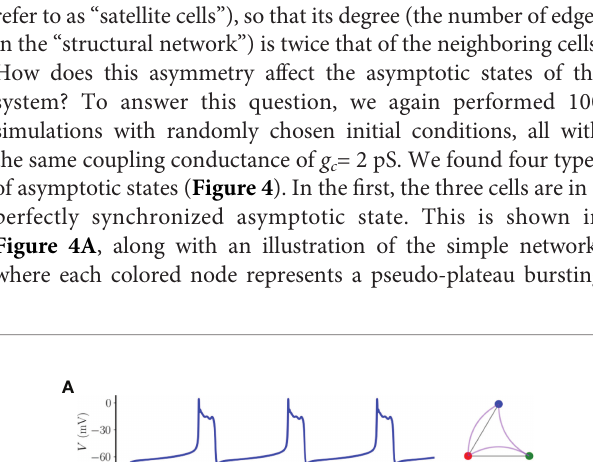
FIGURE 1 | Two model pituitary lactotrophs, denoted as cells i and j , are bidirectionally coupled with coupling conductance g c and a total coupling current of magnitude g c |( V i − V j )| .